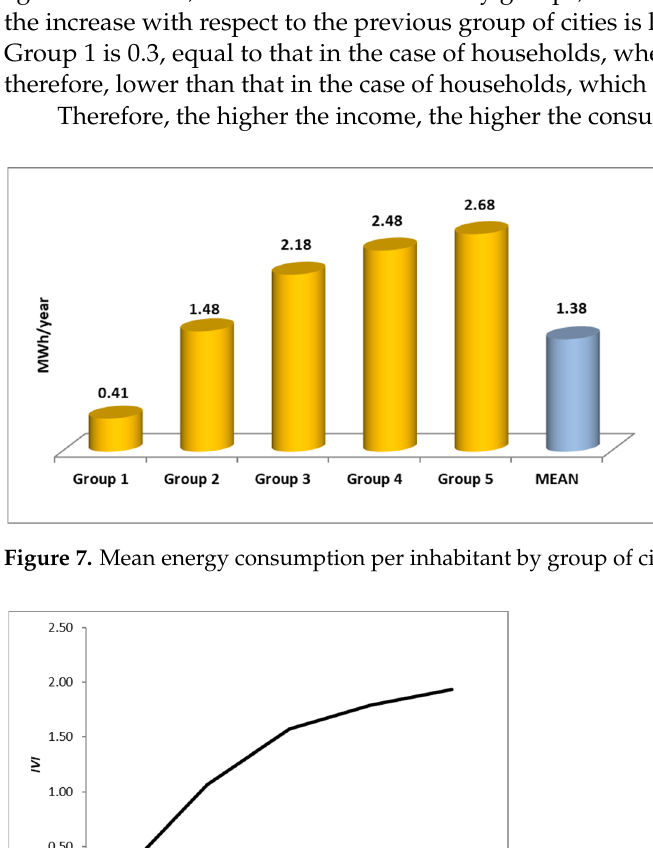
Table 5. Statistical data of inhabitant consumption.